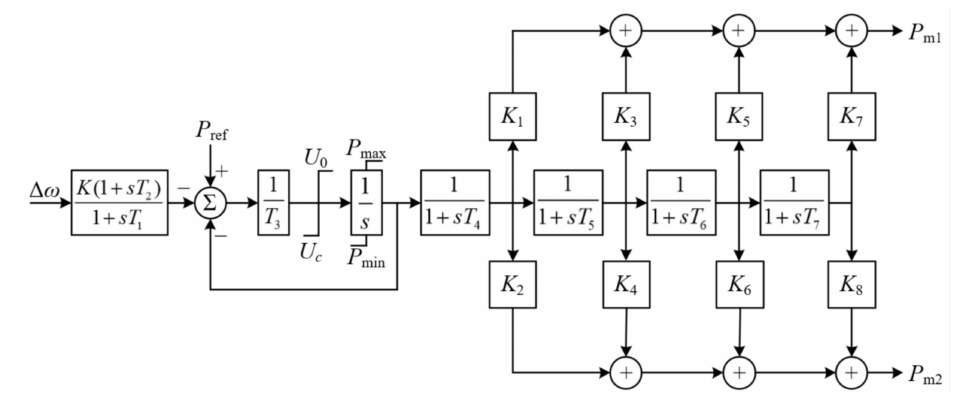
Figure 5. IEEEG1 steam governor